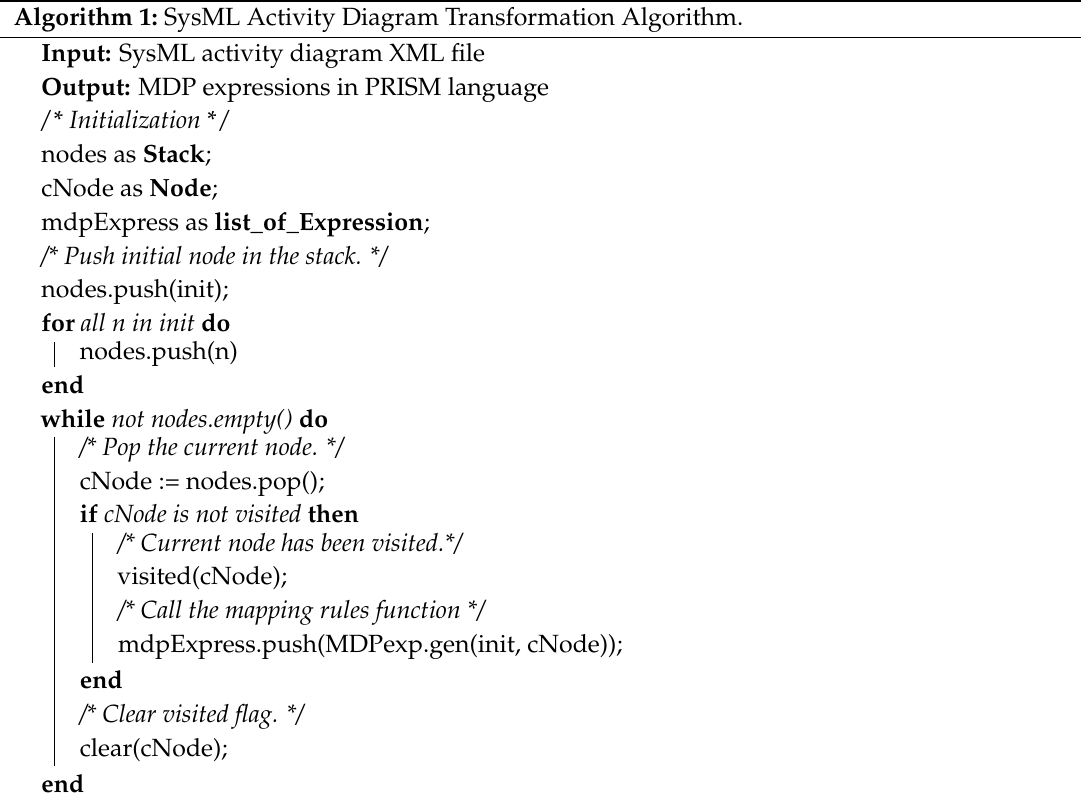
Algorithm 1: SysML Activity Diagram Transformation